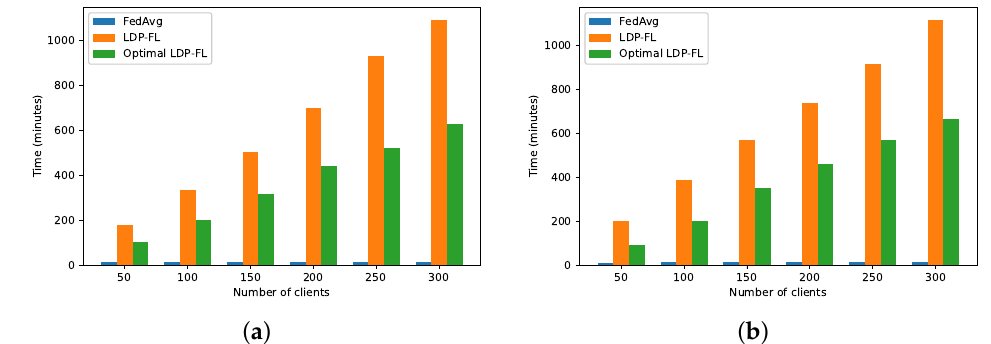
Figure 5. Time vs. number of clients for different federated learning frameworks on MNIST and Fashion MNIST datasets: ( a ) MNIST and ( b ) Fashion